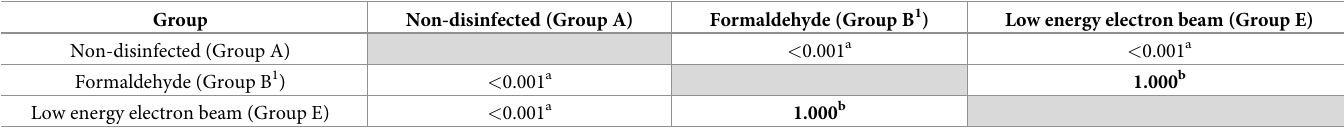
Table 3. Statistical data analysis of the low energy electron beam independent disinfection trial including non-disinfected as control group and formaldehyde as golden standard. The analysis was performed using the cfu/ml count of two trials combined per group and the historical non-disinfected re-isolation values of flock 426.